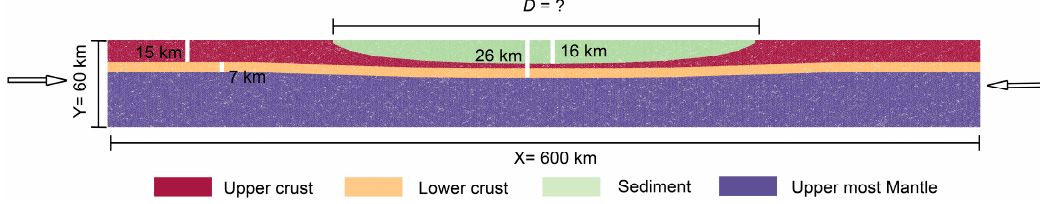
Figure 6. 2D thermo-mechanical model. The convergent rate is set to 2.5 mm/year on either side. In the upper crust, we define a 16 km thick volcano-sediment in the center overlaying the 10 km thick crustal layers (including 3 km mafic crust and 7 km lower crust). The width of sediment ( D ) is variable according to different cases listed in Table 2. Table 2. Parameters for each model, Exp # represents the name of experiment. Width of Sediment ( D =